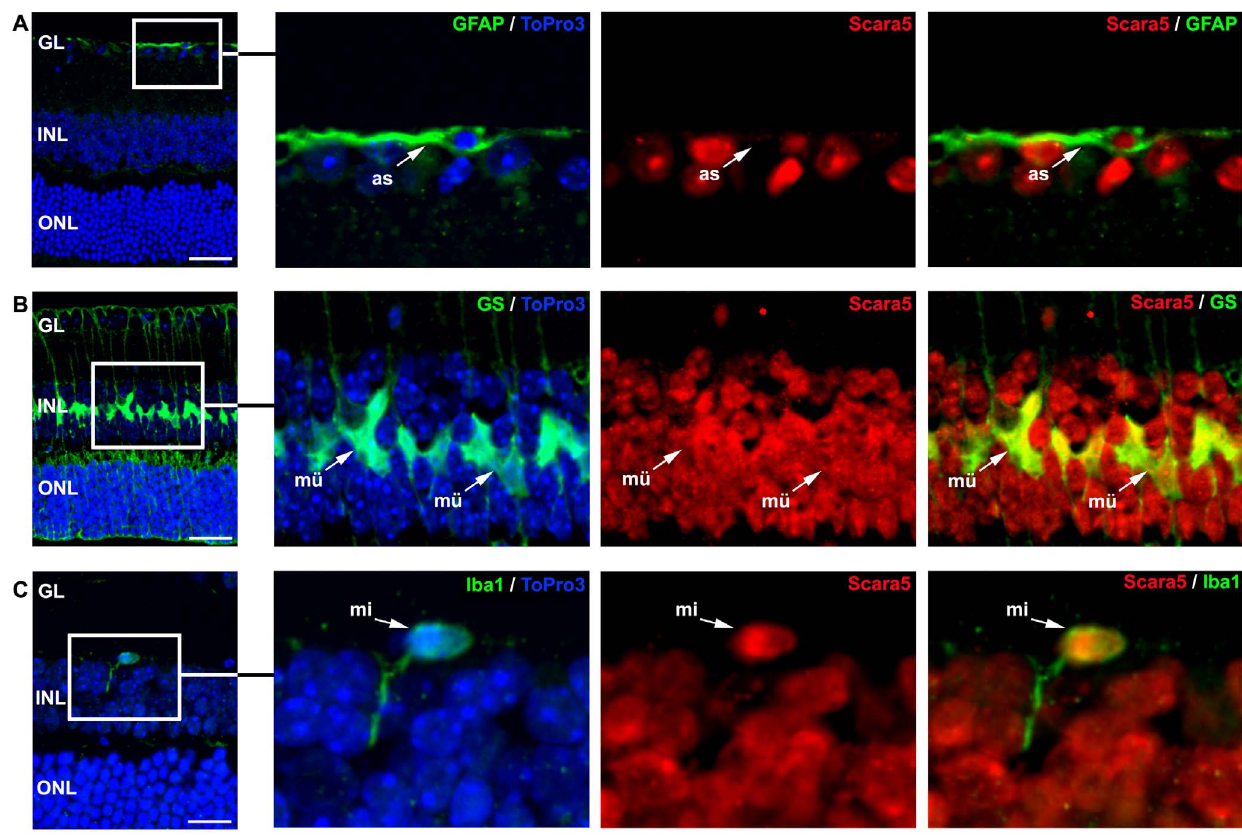
Figure 4. Scara5 was expressed in retinal glia. A: Labeled astrocytes with GFAP showed Scara5 expression. B: GS positive Mu¨ller cells presented intense Scara5 signal both at the nuclear and cytoplasmic compartments. C: Microglial cells revealed a more intense Scara5 signal in nucleus than in cytoplasm. Nuclei were counterstained with ToPro3. as, astrocyte; mu¨, Mu¨ller cell; mi, microglial cell. GL, ganglion cell layer; INL, inner nuclear layer; ONL, outer nuclear layer. Scale bars: 33 m m (A); 33 m m (B); 14,7 m m (C).